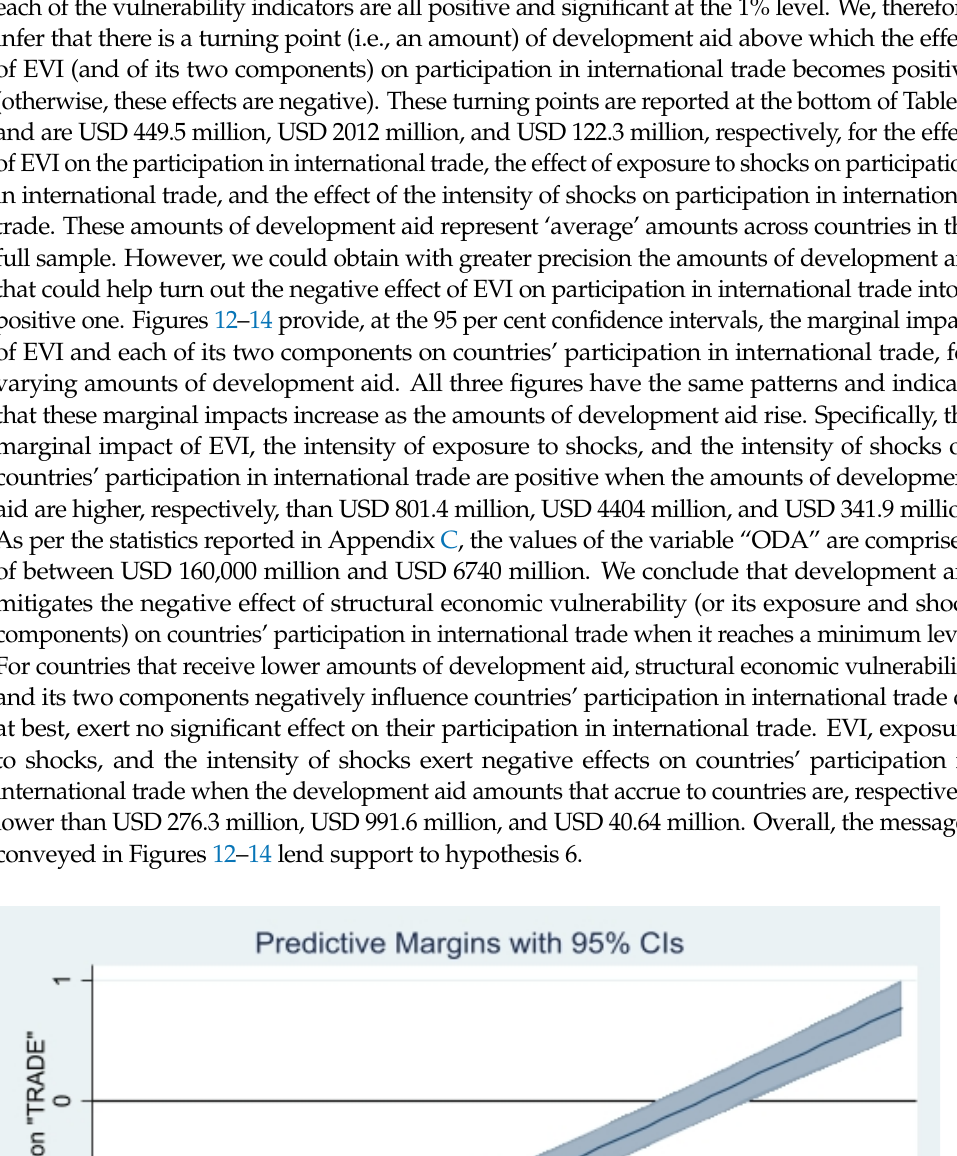
Figure 13. Marginal impact of “EXPOS” on “TRADE” for varying amounts of development aid. Source: Author.